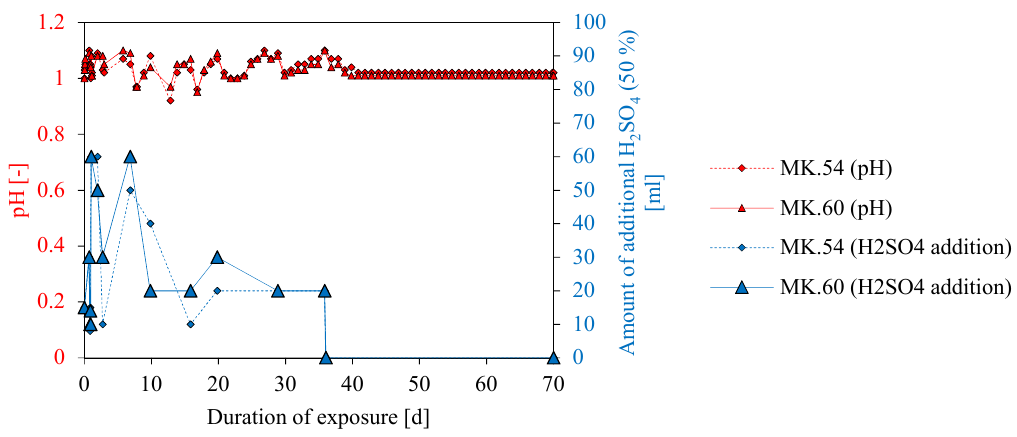
Figure 8. pH of the sulfuric acid solution for MK54 and MK60 over the complete exposure time (70 days) and amount of sulfuric acid (50%) addition to maintain a constant pH in the range of 1.